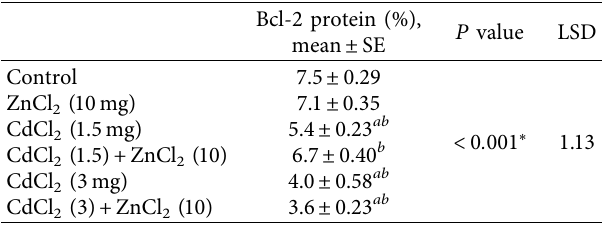
Table 3: Bcl-2 protein percentage in mice hepatocytes exposed to cadmium and zinc chloride calculated using ImageJ